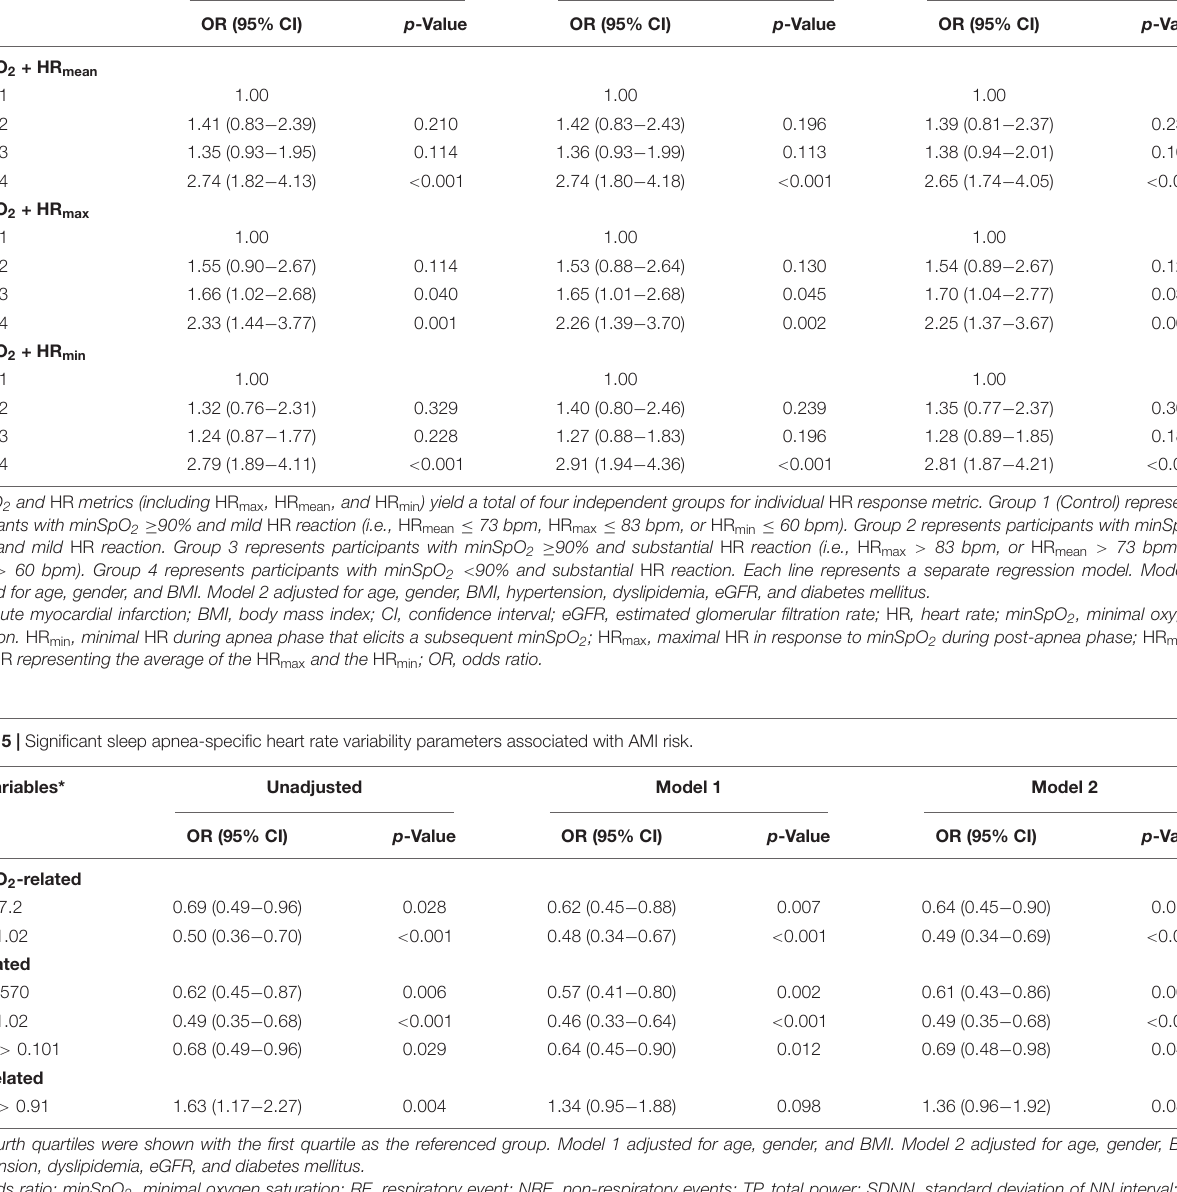
TABLE 4 | Associations of composite metrics of minSpO 2 and minSpO 2 -specific HR metrics with AMI. Unadjusted Model 1 Model 2